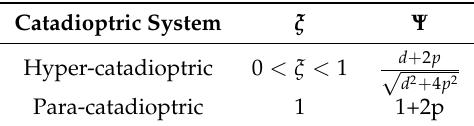
Table 2. Definition of Ψ and ξ for different